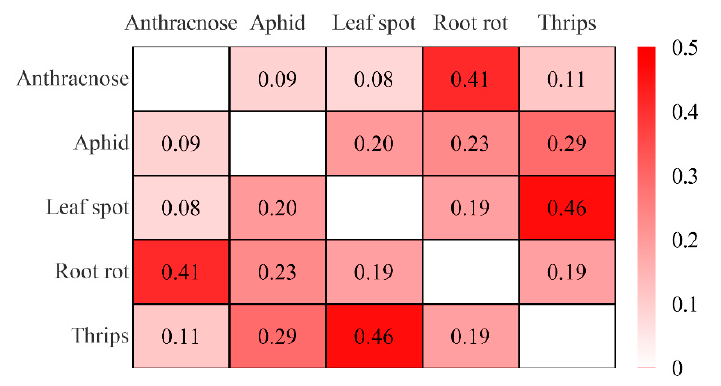
Figure 7. Similarity indexes between diseases and pests of strawberry.